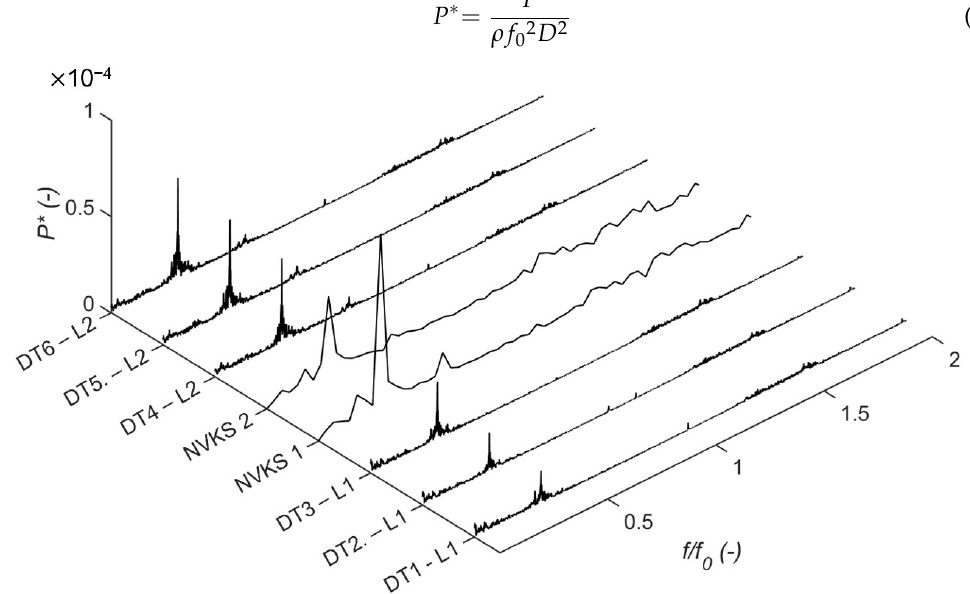
Figure 4. FFT compares the current test rig pressure signals at the PL2 operating condition with the old NVKS model [43].